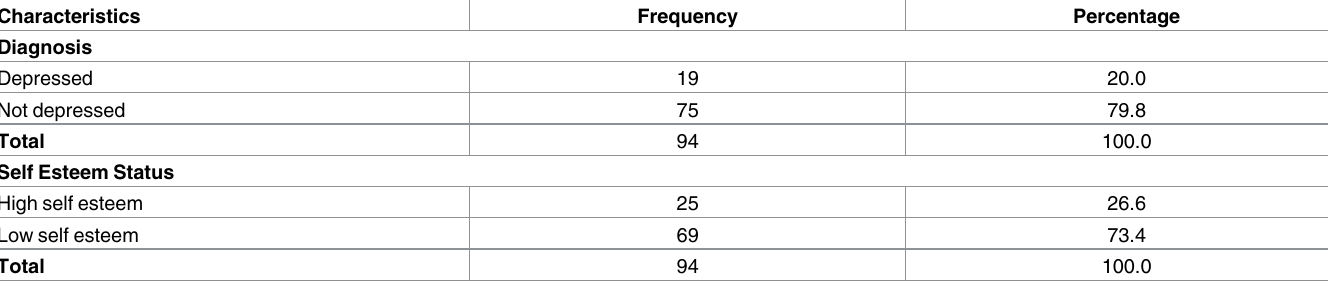
Table 3. Prevalence of depression and low